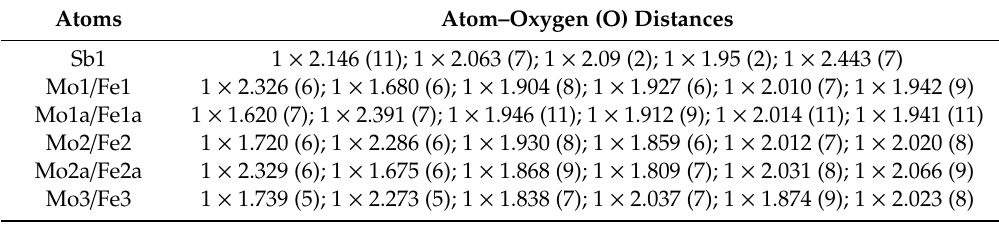
Figure 2. ( a ) The [SbO 3.5 ] n chains and the [(Mo3/Fe3)O 5 ] n chains form together [(Mo3/Fe3)SbO 6.5 ] n chains, ( b ) [(Mo1*/Fe1*)O 5 ] n and [(Mo2*/Fe2*)O 5 ] n chains form layers with the composition